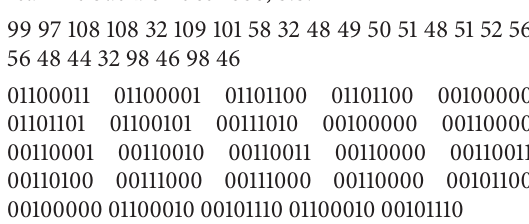
Figure 9: Example of the simple process to smooth the accelerome- ter signal and applying a dynamic threshold to produce a pulse train in which the width of each pulse is the delay of one of two alternate vibration states, on or off. The hidden message is encoded in those delays: the on state represents one or more 1 bit and off state stands for one or more